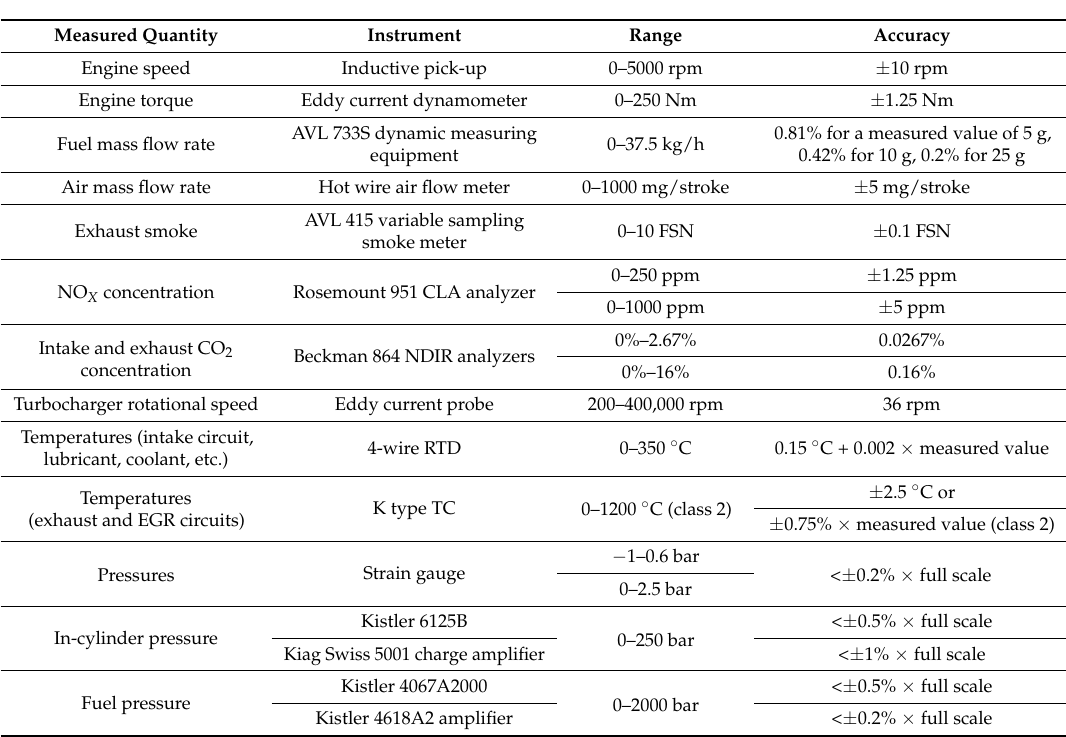
Table 2. Measured parameters and instrumentation. FSN: filter smoke